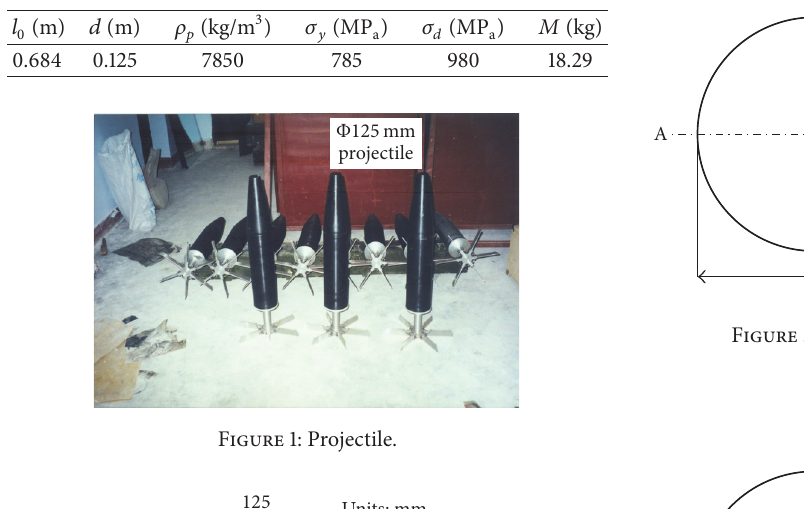
Table 1: Parameters of projectile.